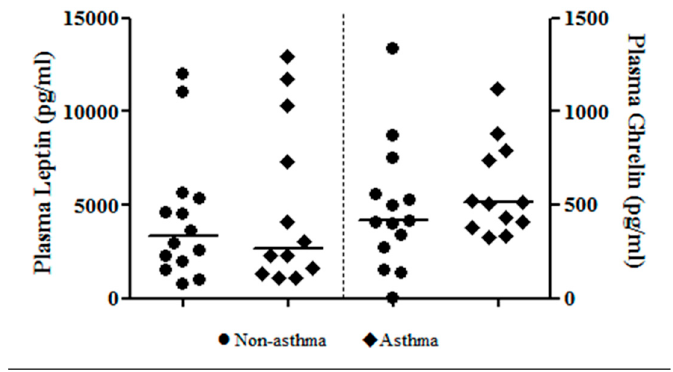
Figure 1. Fasting plasma levels of appetite hormones in children referred for an overnight polysomnography, asthma vs. non-asthma (ghrelin, p = 0.328; and leptin, p = 0.959).